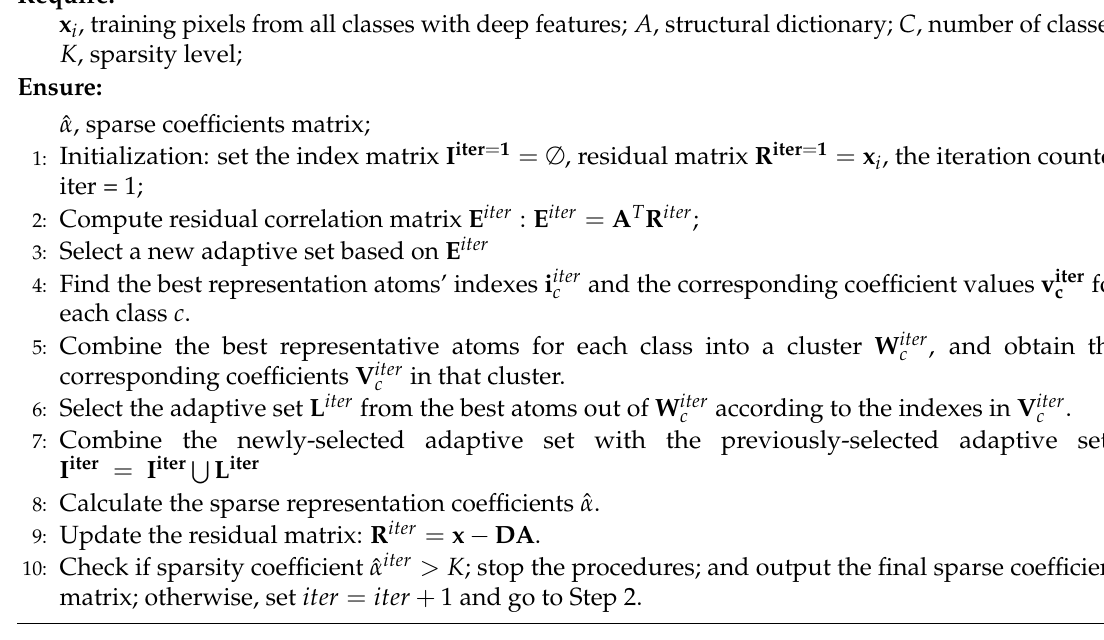
Algorithm 1 Framework of the deep feature-based sparse